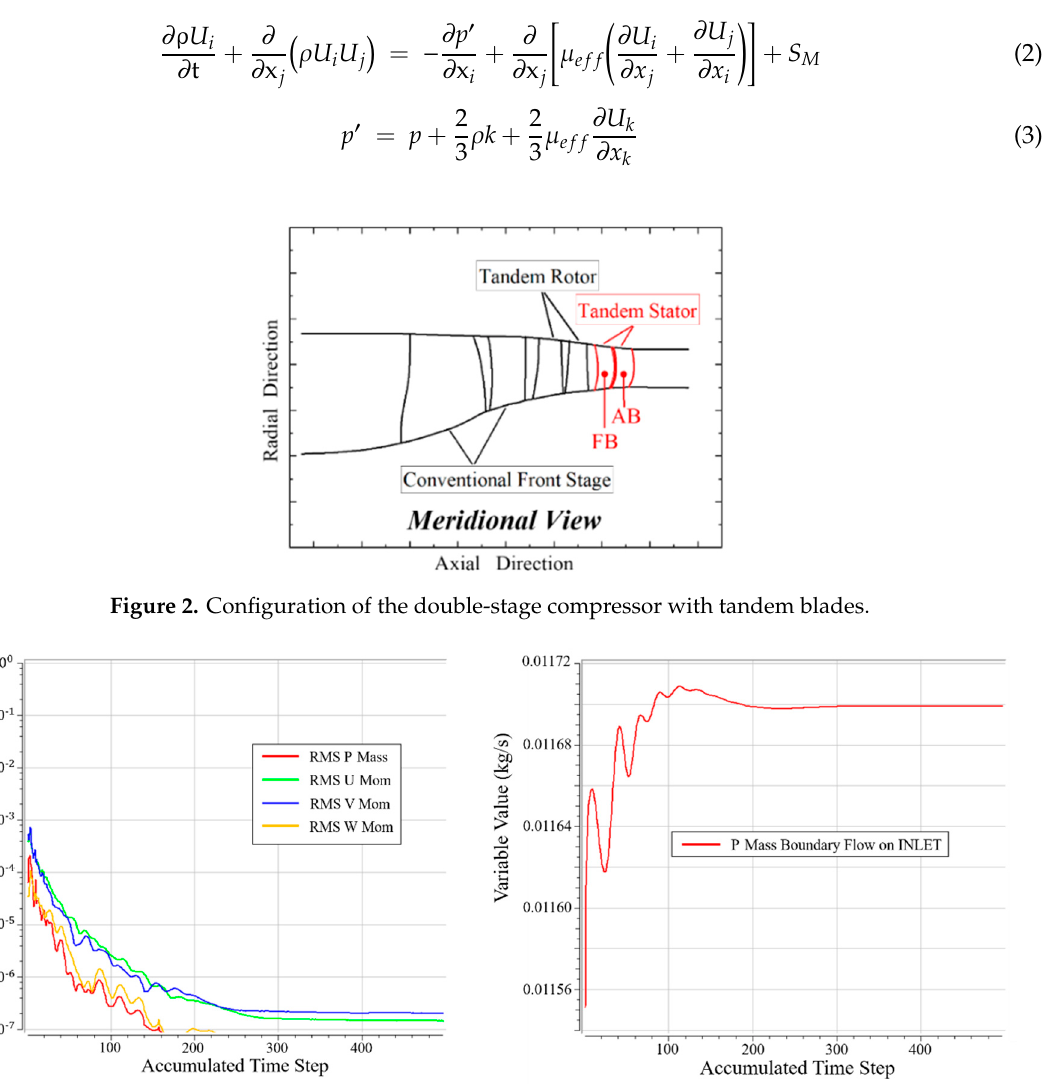
Figure 2. Configuration of the double-stage compressor with tandem blades.